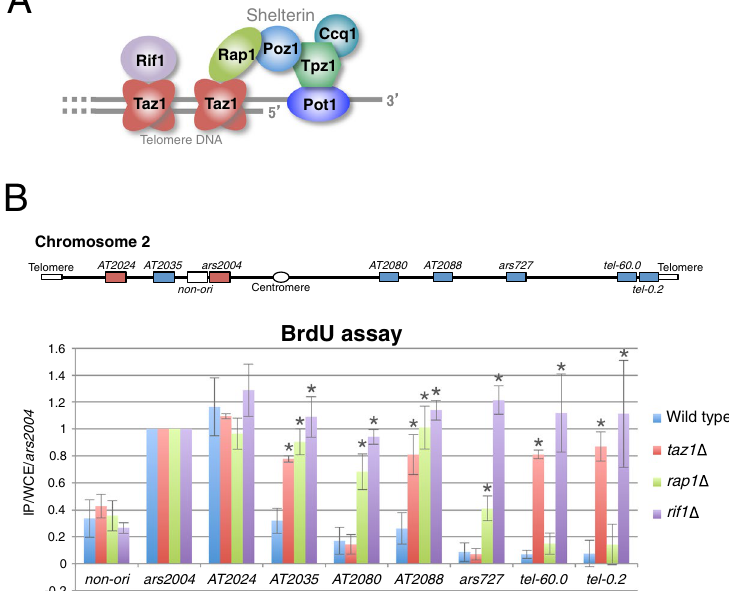
Figure 1. Rap1 deletion accelerates DNA replication from internal late origins. ( A ) Schematic illustration of telomere-binding proteins in S. pombe . ( B ) Replication timing of late origins is affected by Rap1 deletion. The locations of replication origins on chromosome 2 are schematically illustrated at the top. AT2024 and ars2004 are early origins (red squares), and AT2035 , AT2080 , AT2088 , ars727 , tel-60.0 , and tel-0.2 are late origins (blue squares). The subtelomeric late origins tel-60.0 and tel-0.2 are located at 60.0 and 0.2 kb, respectively, from the telomere of the right arm of chromosome 2. The non-origin region ( non-ori ) is located at 30 kb from ars2004 . Wild type, taz1 ∆ , rap1 ∆ , and rif1 ∆ cells were grown in EMM medium and released from G 2 /M arrest, and their DNA was labeled with BrdU for 90 min in the presence of 10 mM HU, purified by immunoprecipitation, and analyzed by qPCR. Each value was normalized to that of ars2004 . Error bars indicate the s.d. ( n = 3). Asterisks indicate a significant change as compared with the wild-type strain ( p < 0.05, Student’s